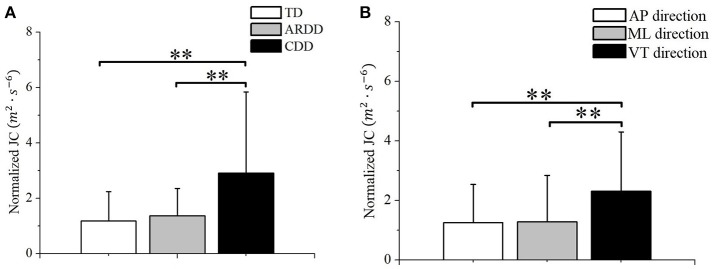
(A) Group difference between typical developing infants (TD), infants at risk of developmental delay, and infants with confirmed developmental delay (CDD) in the movement smoothness quantified by the averaged JC value across directions; (B) Direction difference between anterior-posterior (AP) direction, medial-lateral (ML) direction, and vertical (VT) direction in the movement smoothness quantified by the averaged JC value across groups. **indicates p < 0.01.